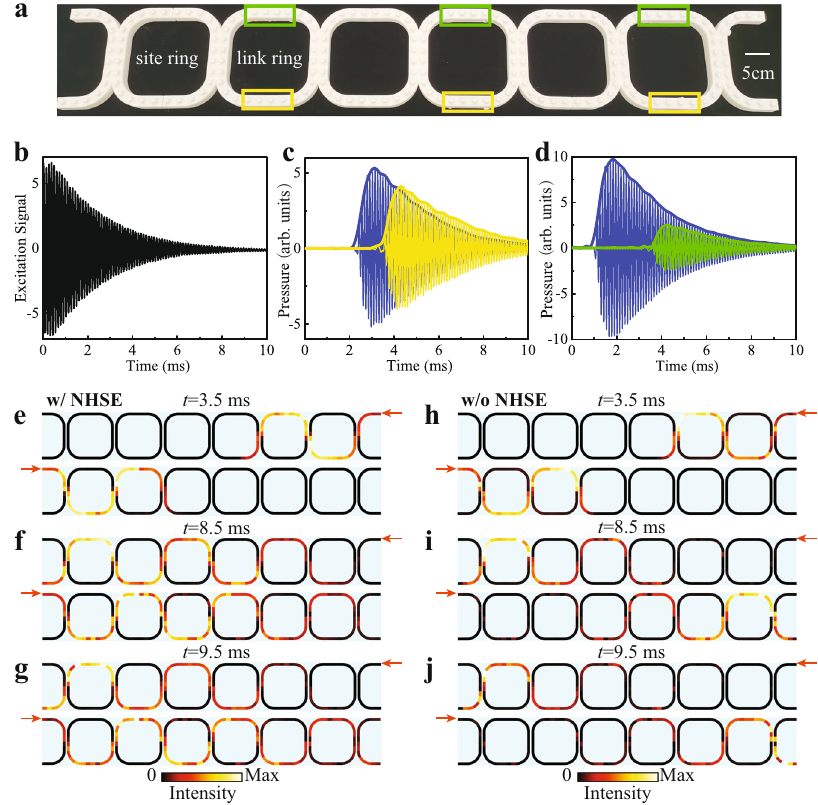
Fig. 4 | Experimental demonstration in a 1D acoustic lattice. a Photo of the 3D- printedexperimentalsample,consistingofsixringresonatorsandtwohalfringson theboundaries.Thegreenandyellowboxesindicatetheareaswithadditionalloss. b The measured electric signal imposed on the loudspeaker. c The time evolution of sound pressure for the left-moving acoustic wave. The signals are measured at the middle position of the fi rst site ring (blue) and second site ring (yellow), respectively. d The time evolutionofsound pressurefortheright-moving acoustic